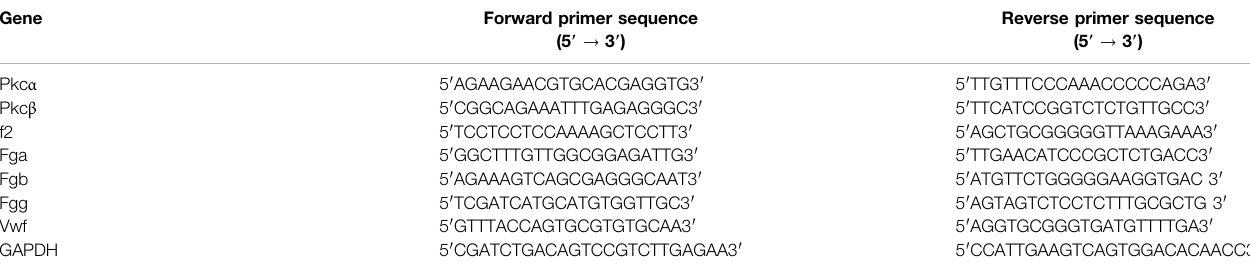
TABLE 1 | The gene primer sequence used for RT-qPCR.